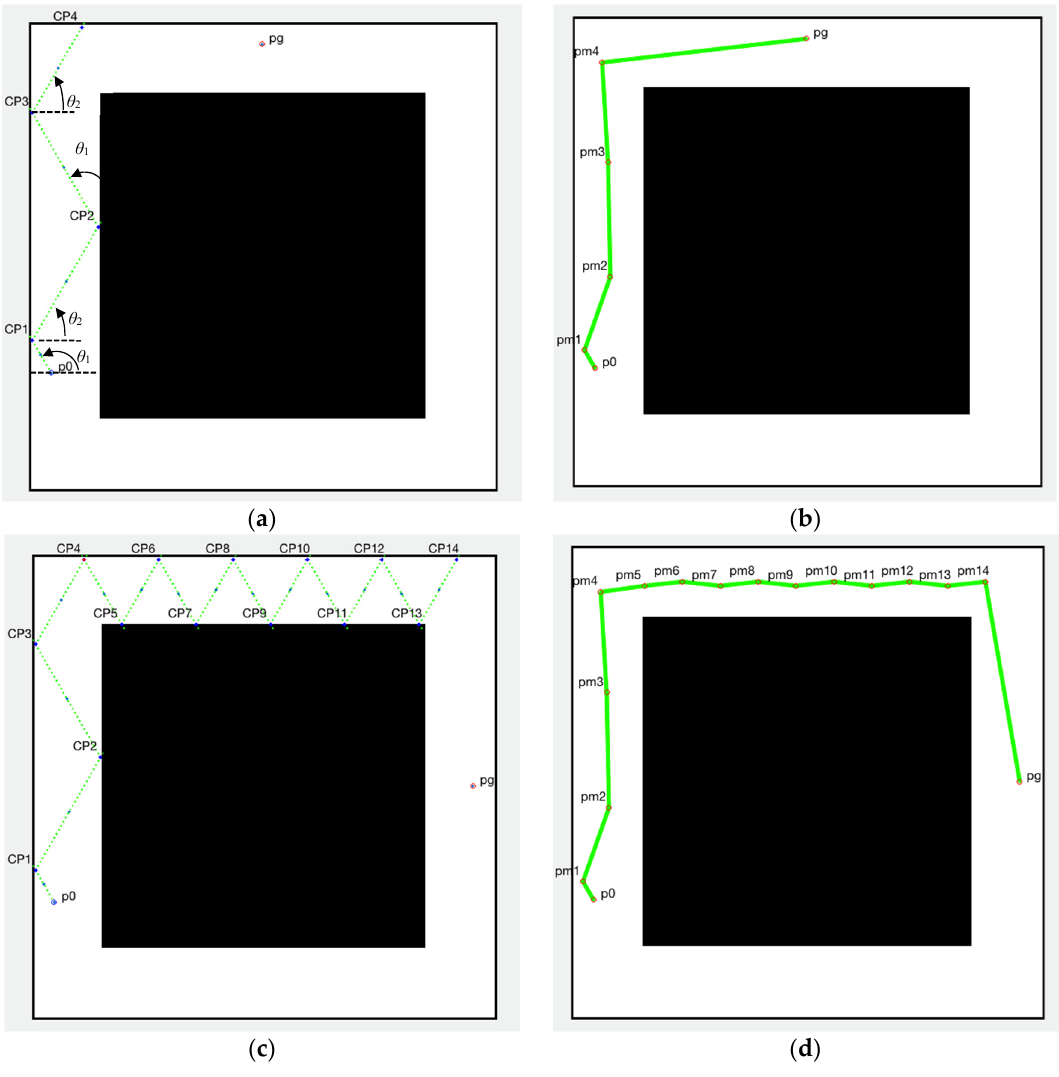
Figure 5. Example of the Search for Cross Points (SCP) working between p 0 and p g with initial angle θ 0 = 60°. ( a ) Scenario without change of direction; ( b ) Obtained trajectory in scenario without change of direction; ( c ) Scenario with change of direction; ( d ) Obtained trajectory in scenario with change of direction.